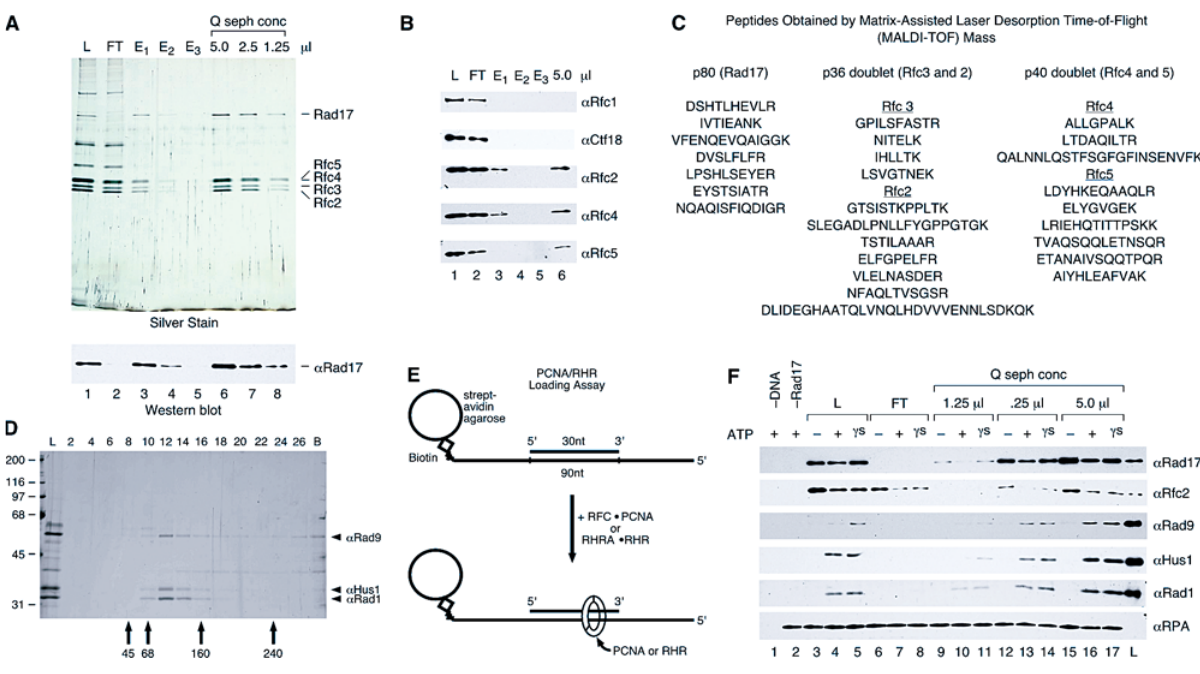
Figure 1. The Purified Human RSR Complex Can Load the RHR Complex onto DNA In Vitro (A) RSR was purified from the Rfc2 Ab affinity column eluate by anti-Rad17 Ab affinity chromatography, and the peptide-eluted material was concentrated by Q–sepharose chromatography. An equivalent volume (5 l l) of the load onto the anti-Rad17 column (lane 1, labeled L), the flowthrough from the column (lane 2, labeled FT), each peptide elution fraction (lanes 3–5), and the indicated amounts of the concentrated, purified complex (lanes 6–8) were analyzed by silver staining and Wb for Rad17. (B) The same fractions present in the silver-stained gel in (A) were analyzed by Wb for Rfc1, Ctf18, Rfc2, Rfc4, and Rfc5, and the lanes are as loaded and numbered in (A). (C) Peptide sequences for the proteins present in the purified Q–sepharose fraction. (D) Purification of the RHR. RHR was purified from E. coli by Talon affinity, Q–sepharose, and phosphocellulose chromatography and by glycerol gradient sedimentation (shown here). The load onto the gradient (lane L) and fractions (corresponding to lane numbers) as well as any material in the pellet (lane B) were analyzed by silver staining (shown) and Wb (not shown). Arrows indicate the sedimentation position of protein standards from a gradient prepared in parallel. (E) Assay for RHR and PCNA loading. RHR and PCNA loading were examined by monitoring the binding of the proteins to a DNA–RPA complex bound to streptavidin–agarose beads by Wb of the bead-bound fractions. The DNA substrate consist of a 90 nucleotide (nt) 3 9 biotinylated template and 30 nt primer positioned in the center of the template, resulting in a substrate with 30 nt single-stranded recessed 5 9 and 3 9 ends to which RPA was bound. (F) RSR is sufficient to load RHR onto DNA in vitro. Reactions were performed as described in the Materials and Methods, and the bead- precipitated products were analyzed by Wb for Rad17, Rfc2, Rad9, Hus1, and Rad1. The fractions from the purification shown in (A) were assayed for RHR-loading activity. Lanes represent reactions that contained the same amount of the anti-Rad17 Ab column load (lanes 1, 3, 4, and 5), flowthrough (lanes 6–8), and the Q–sepharose concentrated protein (lanes 9–17) as shown in the silver-stained gel in (A), or no source of Rad17 (buffer only, lane 2). All reactions contained 5 9 and 3 9 recessed primer–template DNA–RPA complex bound to beads (except for that in lane 1, which contained beads alone), 1 pmol of RHR complex, and the indicated nucleotide cofactor (ATP: lanes 1, 2, 4, 7, 10, 13, and 16; ATP c S: lanes 5, 8, 11, 14, and 17) or no nucleotide (lanes 3, 6, 9, 12, and 15). The lane labeled L represents 20% of the input of RHR and